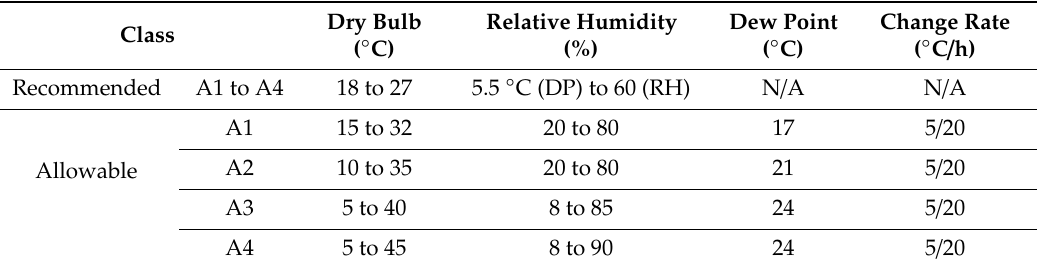
Table 1. Environmental classes for data centers